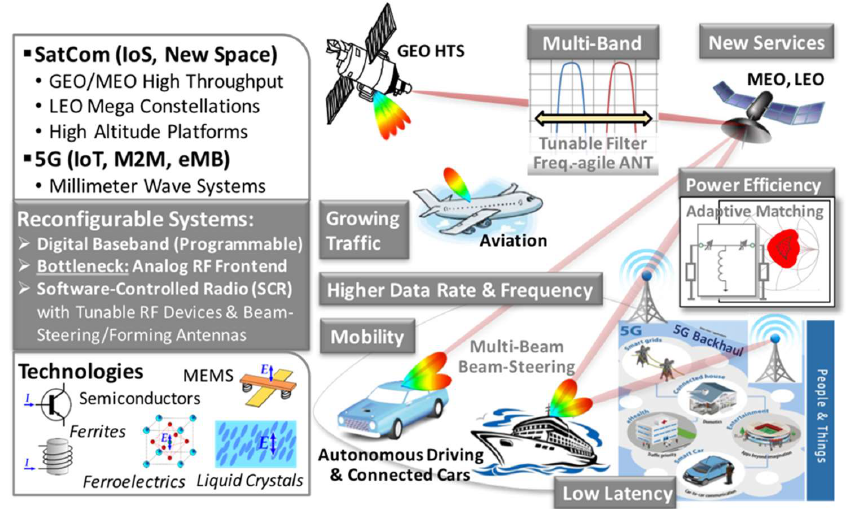
Figure 4. Scenario of various applications and platforms with some important characteristics, including beam-steering antennas and agile components, following the software-controlled radio approach. Reprinted from [2], Cambridge University Press, 2020.